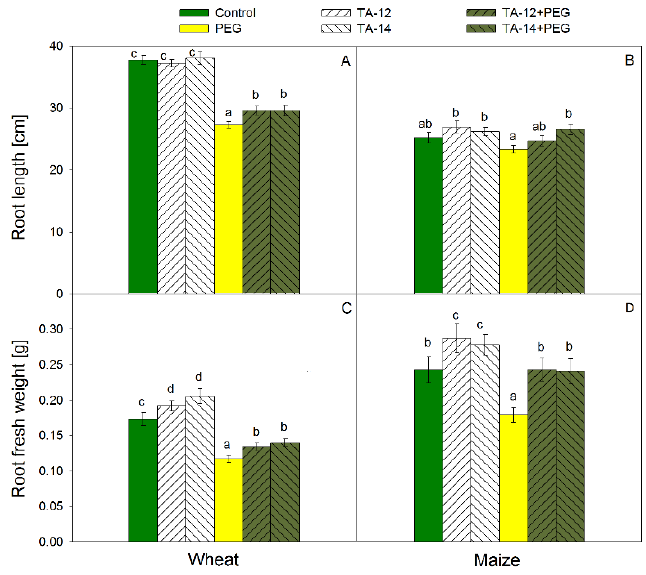
Figure 2. Root length of wheat ( A ) and maize ( B ) and root fresh weight of wheat ( C ) and maize ( D ) foliar sprayed with 1 mM TA-12 or TA-14 and subjected to 10% PEG for 72 h. Data are mean values ± SE. Different letters designate statistically significant difference at p < 0.05.